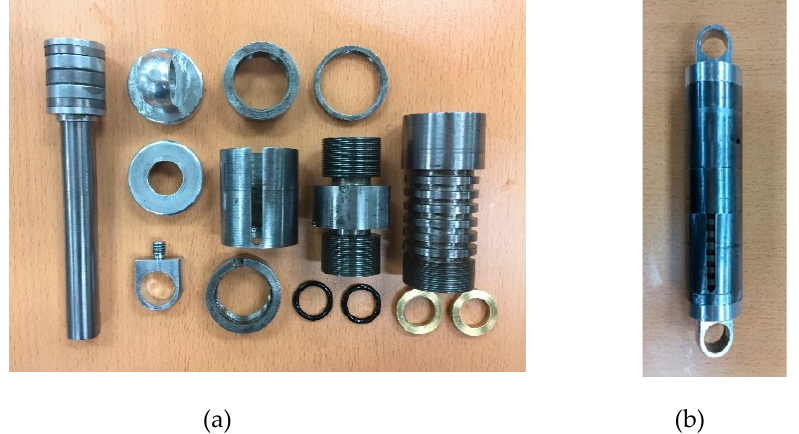
Figure 11. Prototype of the optimized self-powered MR damper ( a ) and its disintegrated components ( b ).